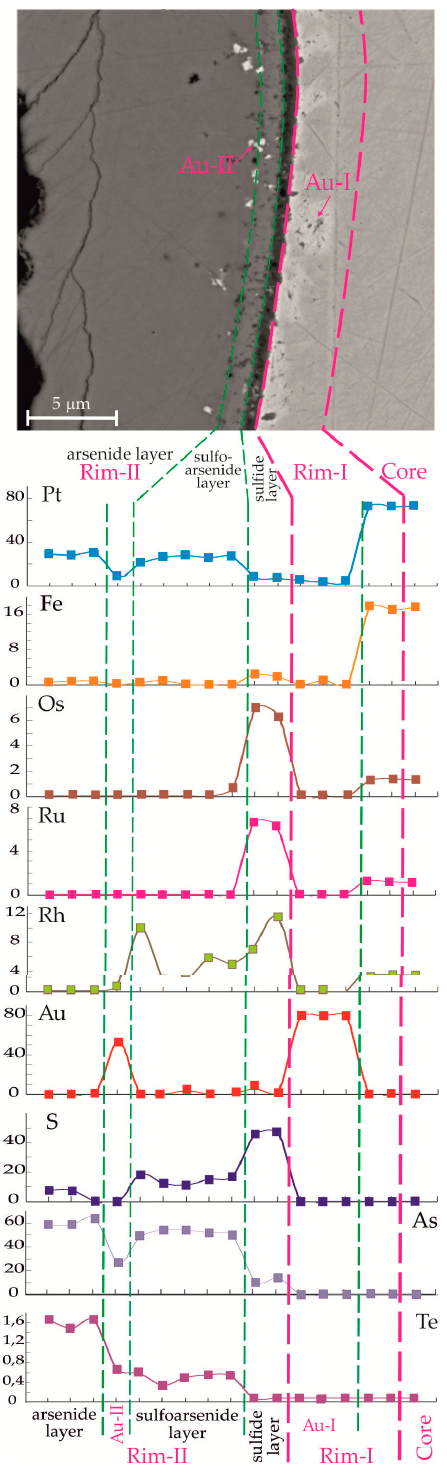
Figure 7. Backscattered-electron (BSE) image (top) and the graphs of changes of the main elements content (at.%) in the Core, Rim-I, Rim-II, with micro-layers in grain No. 3 (see also Figure 4e).